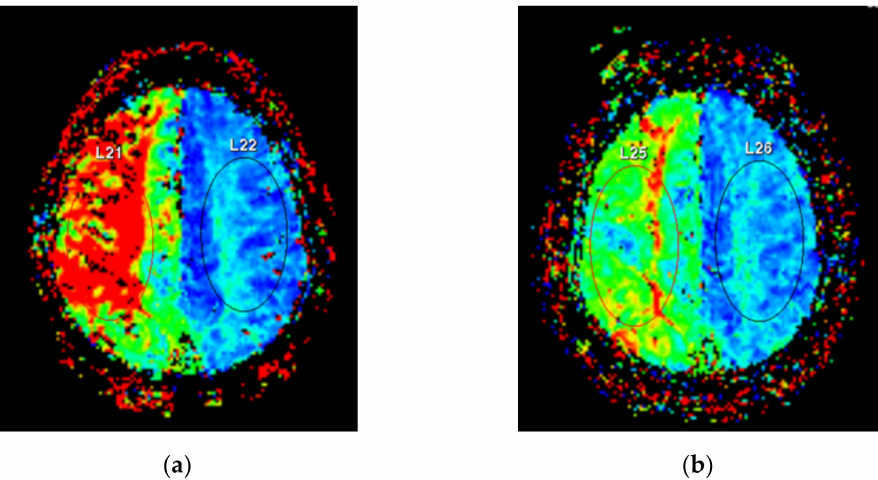
Figure 4. Perfusion weighted magnetic resonance imaging. Regions of interest were located at bilateral centrum semiovale areas. ( a ) Preoperative imaging reveals delayed time to peak at the right subcortical area. ( b ) Postoperative imaging shows improved cerebral perfusion with decreased color difference between the affected and unaffected